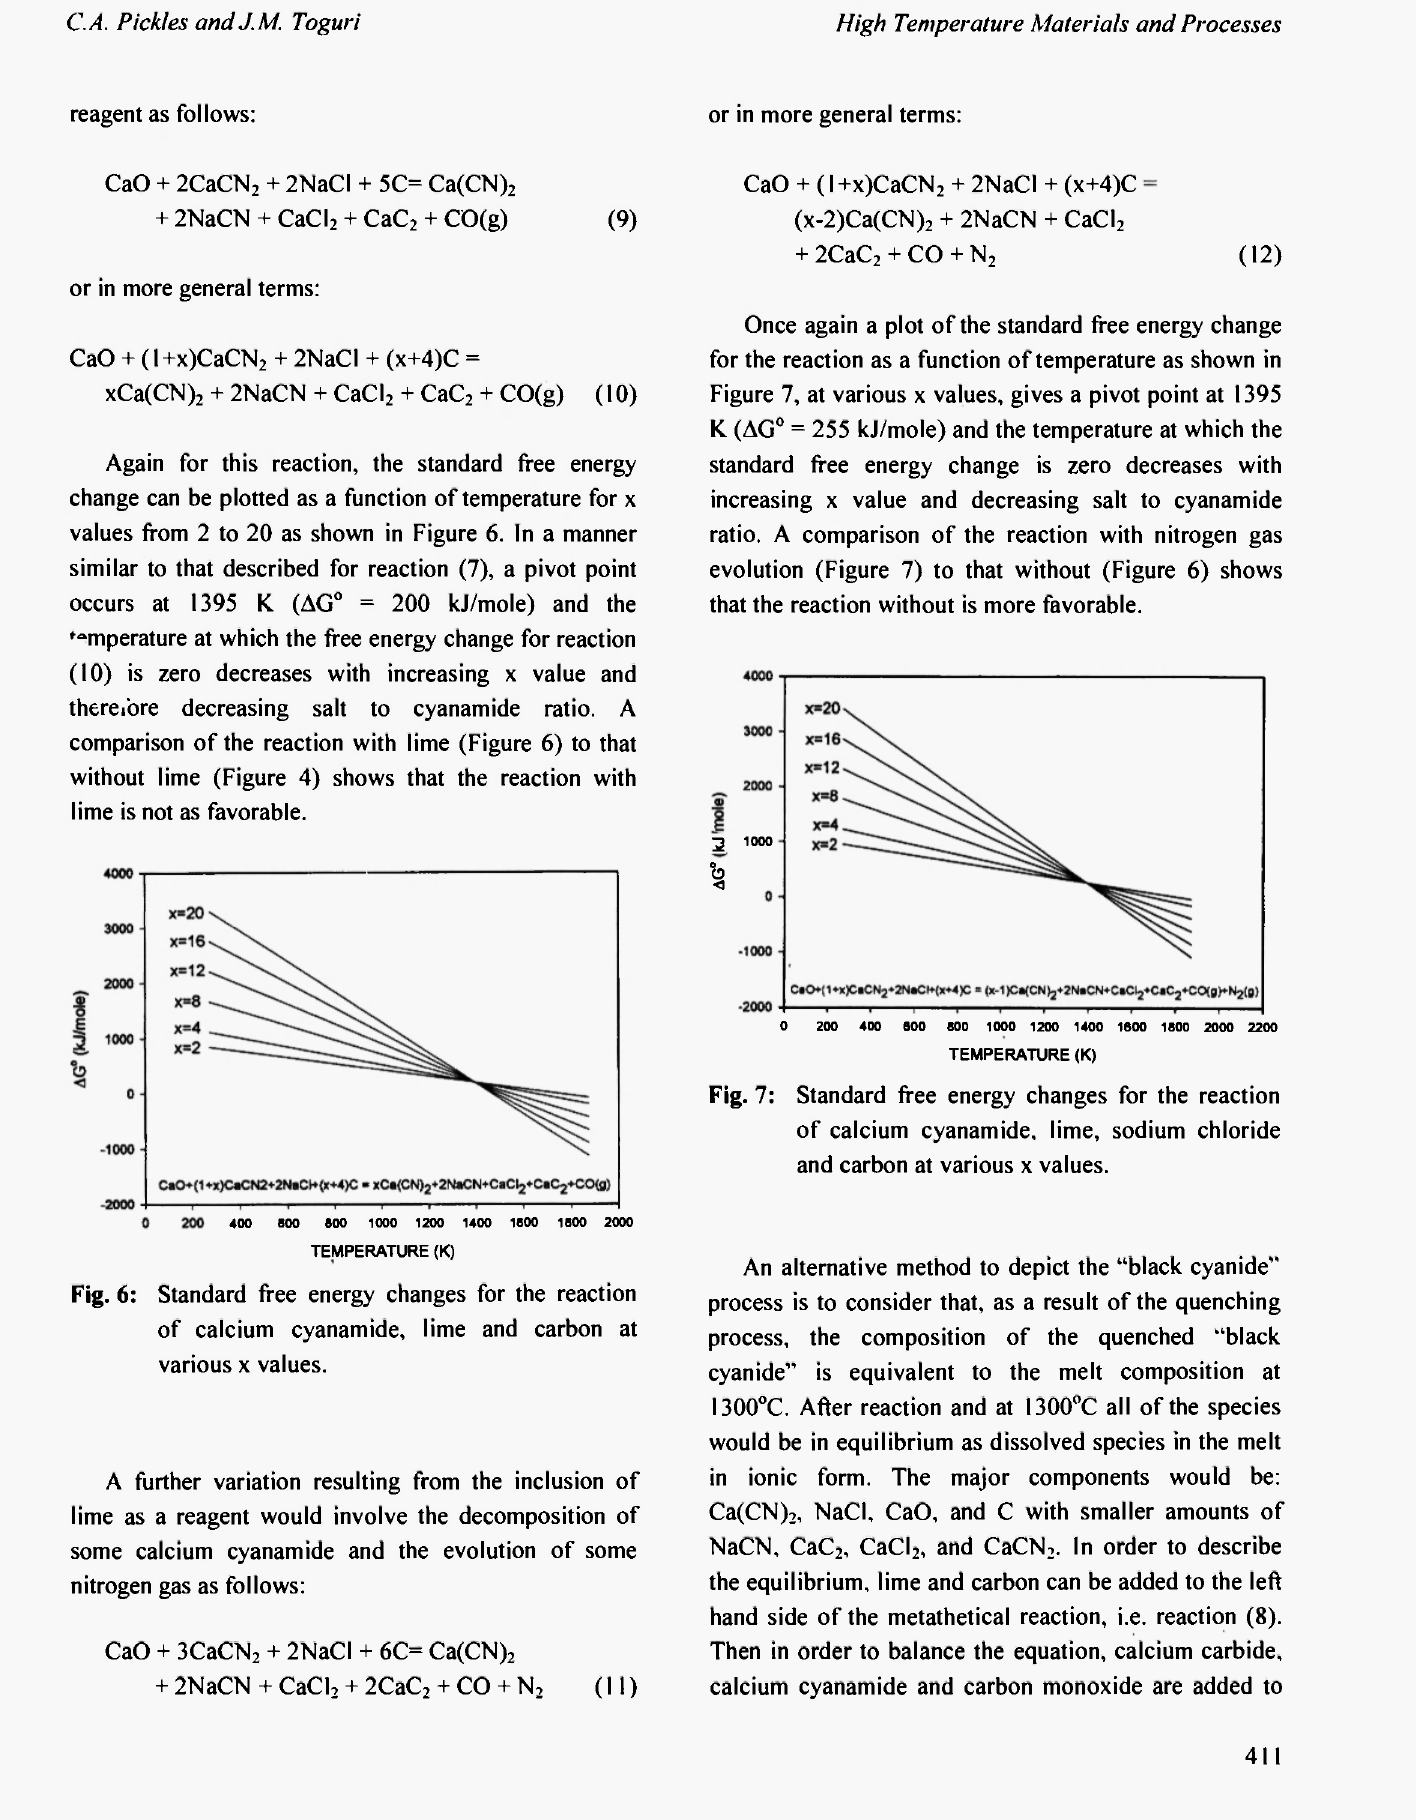
Fig. 6: Standard free energy changes for the reaction of calcium cyanamide, lime and carbon at various χ values.